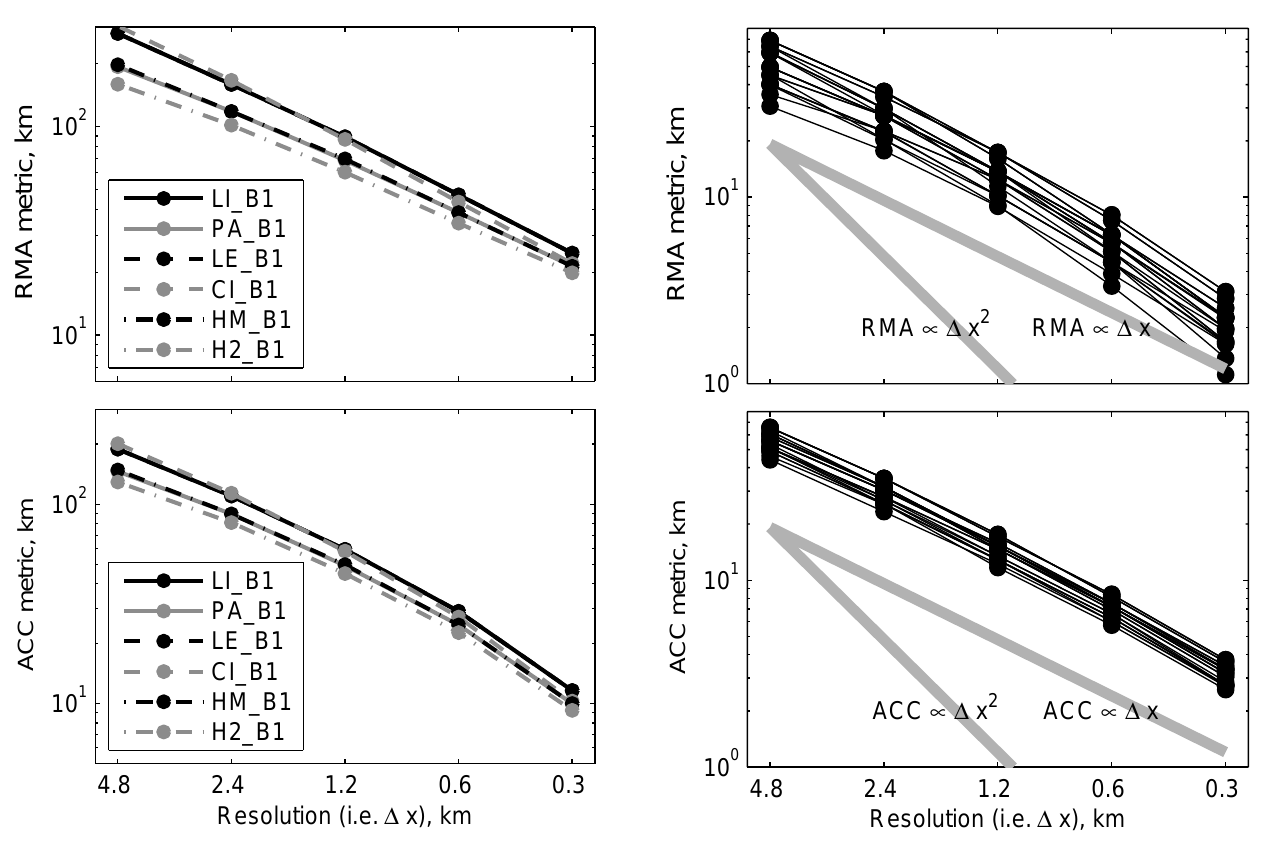
Fig. 11. Error metrics ACC and RMA (Sect. 4.1) against resolution when using the non-linear drag law (Sect. 5.3). Results are shown for all GLPs (see Table 1). Example first order and second order convergence (grey bars) are shown for